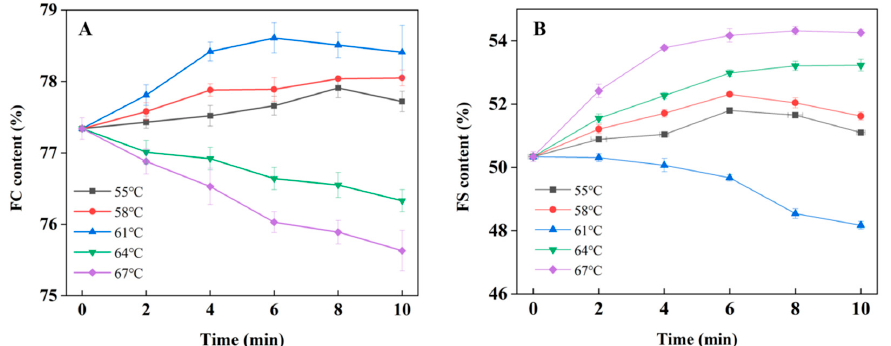
Figure 3. The effect of different heating treatment conditions on the foaming activity of LWE. ( A ): foaming activity (EAI); ( B ): foaming stability (ESI).